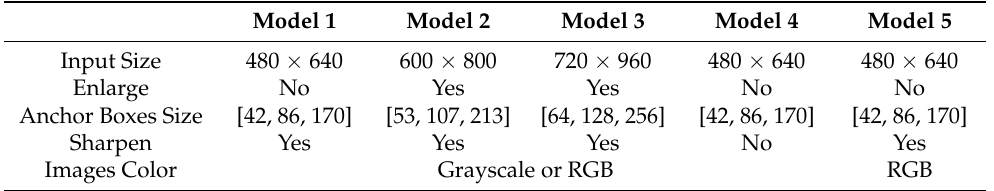
Table 3. Model settings.